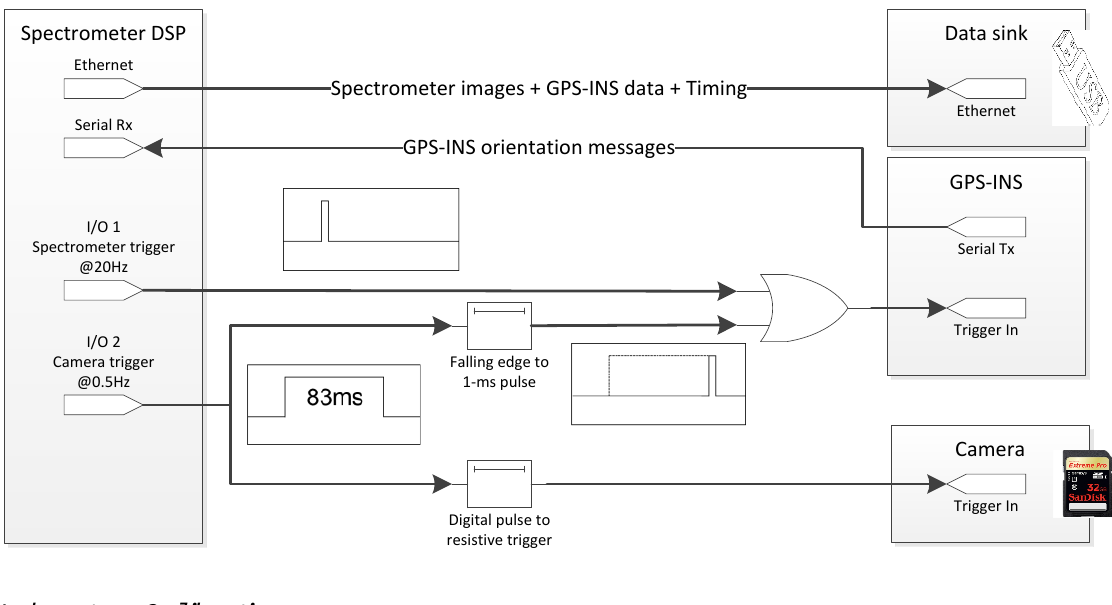
Figure 2. Schematic figure of the HYMSY synchronization pulses and the data flow. The DSP outputs from I/O-1 a 1-ms pulse on every spectrometer exposure (25 Hz) to trigger the GPS-INS. Every 2 s the DSP triggers the photogrammetric camera (Panasonic GX1) with a 83-ms wide pulse from I/O-2. The time lag of 83 ms is the delay between the trigger rising edge and the camera exposure, allowing use of the falling edge of the trigger pulse to synchronize GPS-INS to the camera exposure.